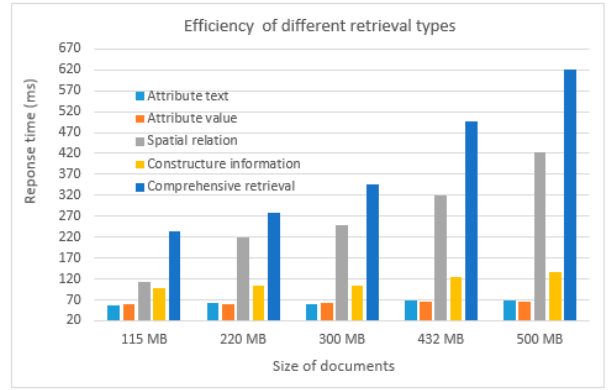
Figure 12. Efficiency of different retrieval types.